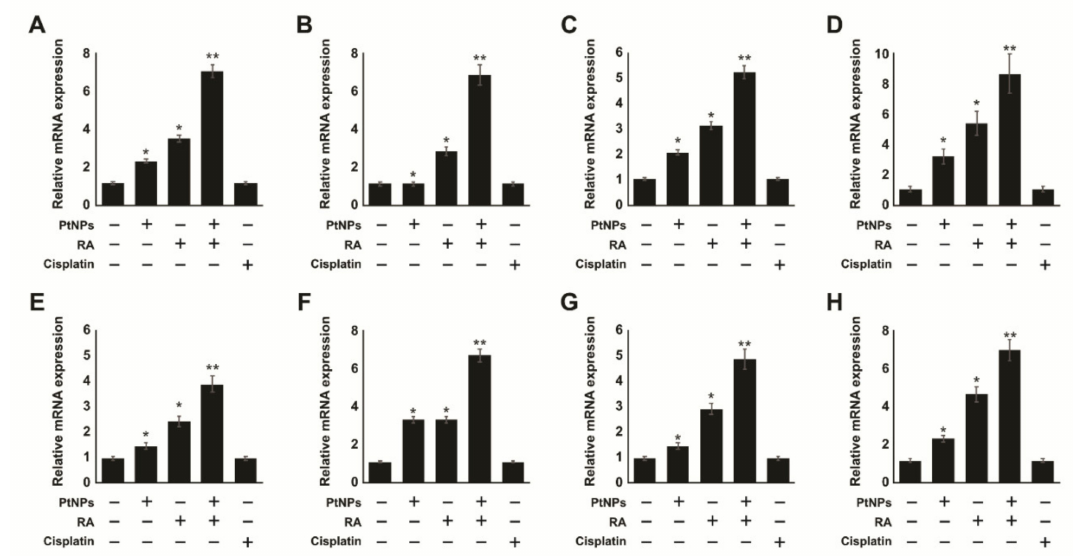
Figure 13. E ff ect of cisplatin on undi ff erentiated and di ff erentiated SH-SY5Y cells. SH-SY5Y cells were pre-incubated with PtNPs (25 µ g / mL), RA (12.5 µ M), or the combination of PtNPs (25 µ g / mL) and RA (12.5 µ M) for 24 h. After preincubation, cisplatin (6.5 µ M) was added to the cells. We examined the expression of various neuronal markers of di ff erentiation, including MAP2 ( A ), beta-tubulin III ( B ), neurogenin ( C ), GAP-43 ( D ), DRD2 ( E ), neurofascin ( F ), neuropilin 1 ( G ), and gamma neuronal ( H ) in SH-SY5Y cells exposed for 24 h. The relative expression levels of all the genes were increased by 4–8 folds after treatment with PtNPs and RA. The results are expressed as mean ± standard deviation from three independent experiments. There was a significant di ff erence between treated cells and untreated cells per Student’s t -test (* p < 0.05). The treated groups showed statistically significant di ff erences from the control group per the Student’s t -test; * p < 0.05 was considered significant, ** p < 0.01 was considered highly